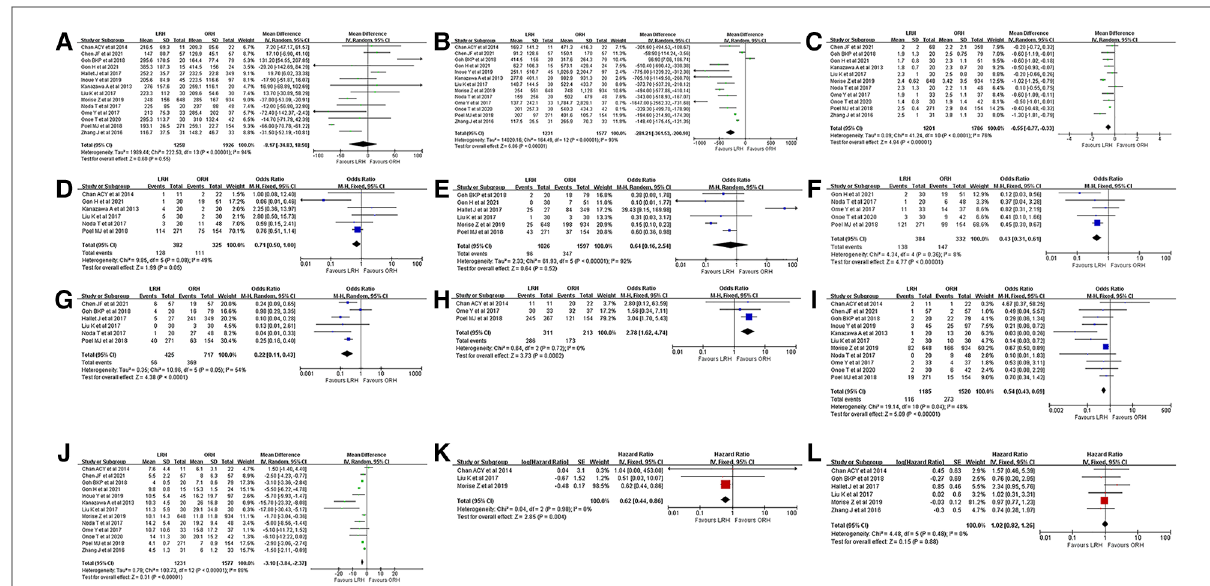
FIGURE 2 Forest plots presenting the intraoperative, postoperative and survival outcomes. ( A ), operative time. ( B ), intraoperative blood loss. ( C ), tumor size (continuous). ( D ), multiple tumors. ( E ), major hepatectomy ( ≥ 3 segments). ( F ), anatomic hepatectomy. ( G ), pringle maneuver. ( H ), R0 resection rate. ( I ), postoperative morbidities. ( J ), hospital stay. ( K ), overall survival (OS). ( L ), disease-free survival